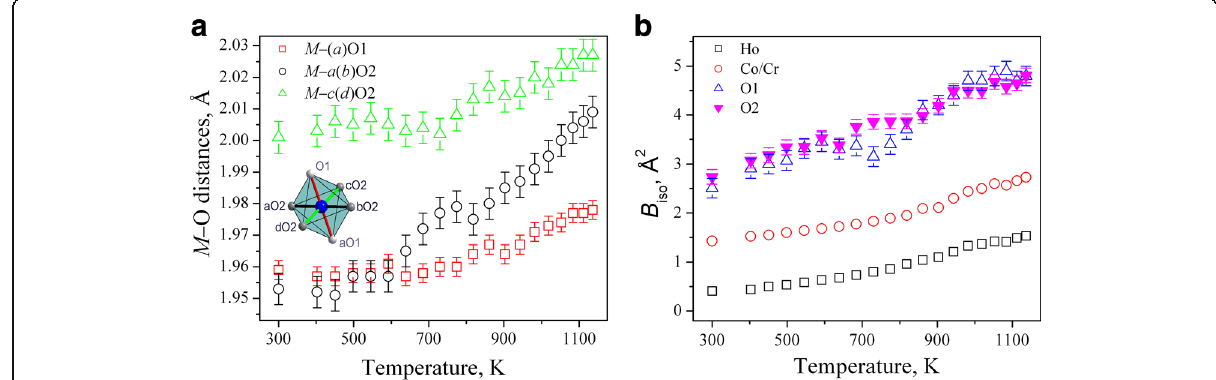
Fig. 4 Temperature evolution of M – O bond lends ( a ) and isotropic displacement parameters of atoms ( b ) in HoCo 0.5 Cr 0.5 O 3